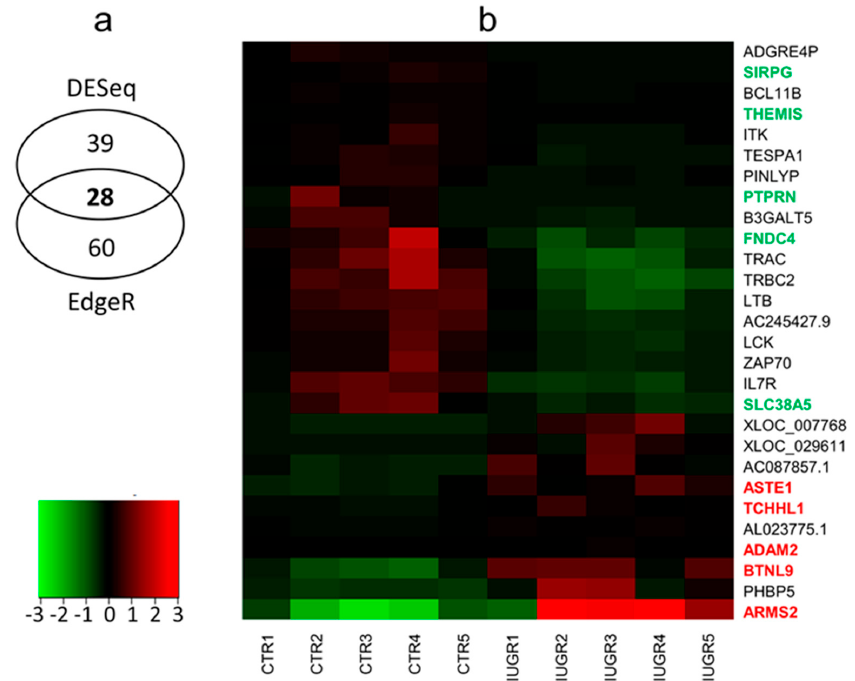
Figure 3. ( A ) Venn diagram with the number of differentially-expressed genes (DEGs) identified by DESeq2 and edgeR. Middle number indicates common DEGs confirmed by both methods. ( B ) Heatmap of expression data for the 28 DEGs (for definitions of gene symbols, see Table 2). Columns represent individual libraries; rows indicate gene symbols of DEGs. The z-score scale was applied for visualization expression values (FPKM) of each biological replicate. Expression profiles of DEGs were prepared for all biological replicates and presented on heatmap (Figure 3B). The five upregulated protein-coding genes were: ARMS2 , ASTE1 , ADAM2 , TCHHL1 , BTNL9 . Five the most downregulated gene were: THEMIS , PTPRN , FNDC4 , SIRPG , SLC38A5 (Table 2). Table 2. List of 28 differentially-expressed genes (under and over-expressed) between IUGR-affected and control libraries.